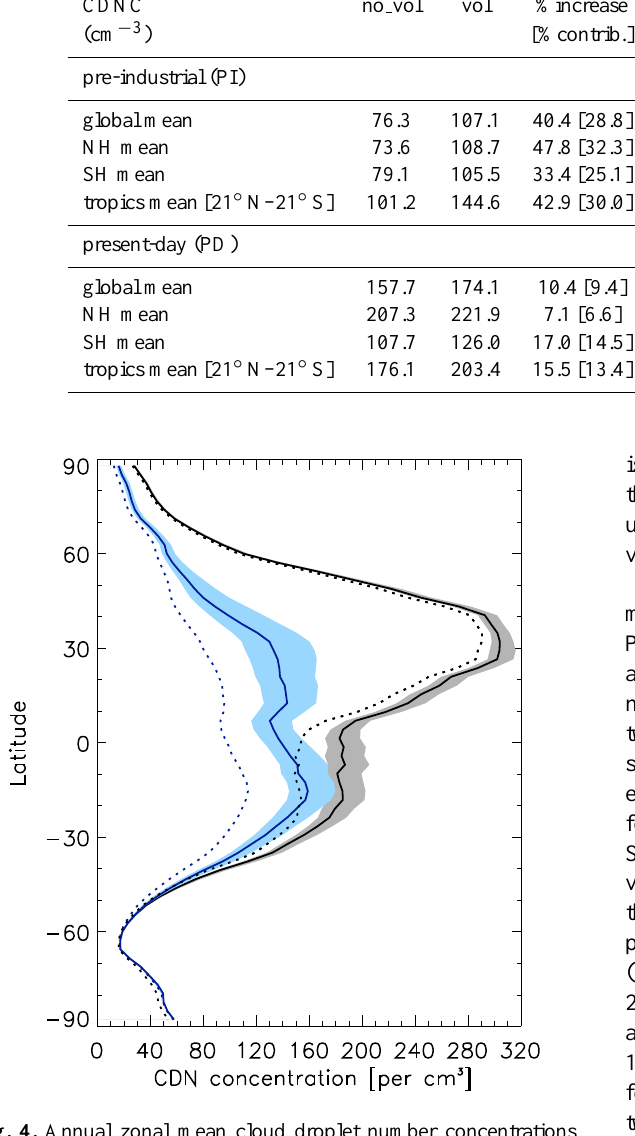
Fig. 4. Annual zonal mean cloud droplet number concentrations (CDNC) at cloud-base altitude (approx. 970m above terrain or sea level) for the pre-industrial era (blue) and for present-day (grey). The dashed lines show the runs where volcanic emissions were omitted; the solid lines show the runs where the volcanic emissions inventory of Andres and Kasgnoc (1998) was used, and the blue and grey shading shows the impact of the − 50%/ + 100% uncertainty in the volcanic sulphur source strength on zonal mean